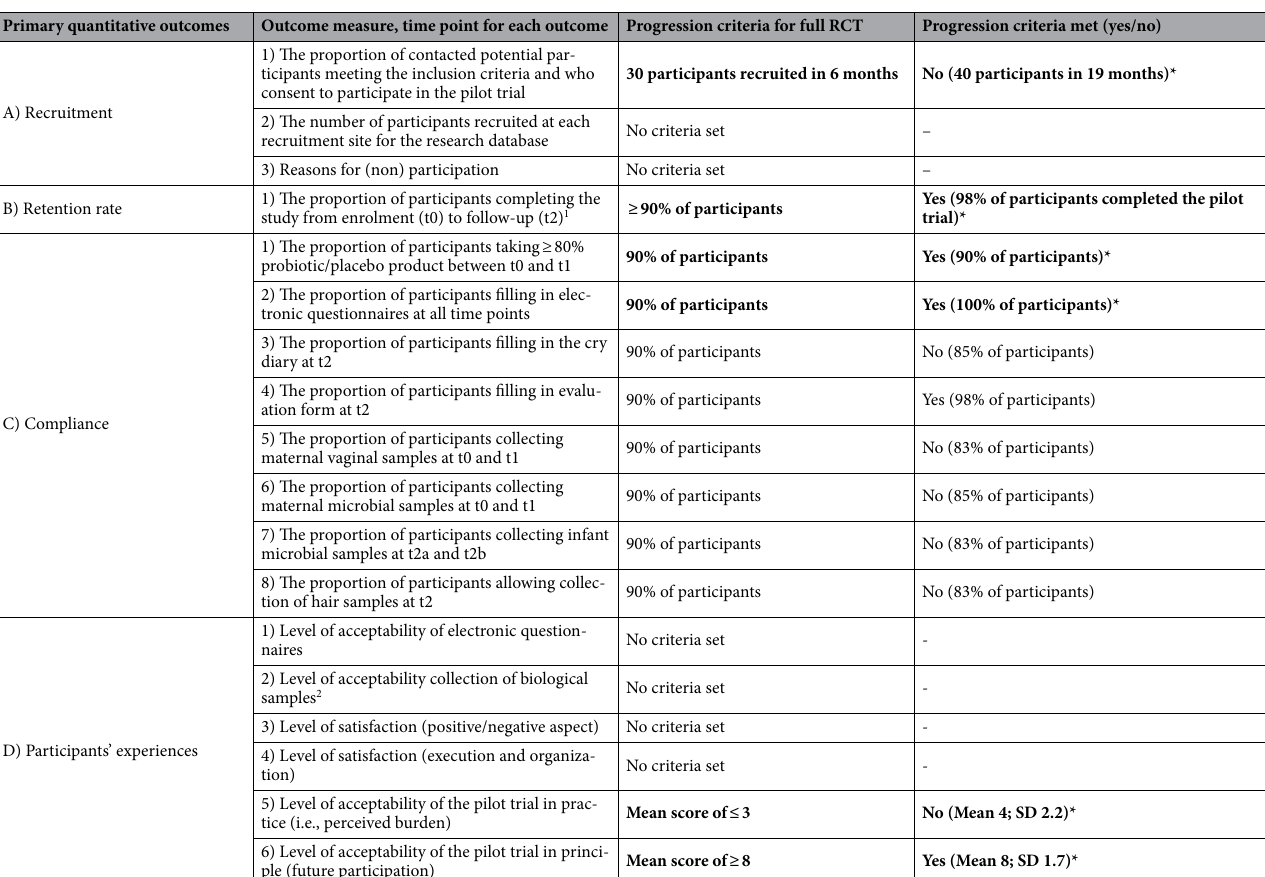
Table 1. Primary quantitative outcomes, outcome measures and time point for each outcome (i.e., baseline (t0), 8 weeks after probiotic/placebo intake (t1) and 4 weeks post-partum (t2), (key) progression criteria for a full RCT, and (key) progression criteria that were met (yes/no). Key progression criteria are bold. 1 Full completion of the study defined as: the closing home visit has taken place at t2. 2 Of the 34 participants